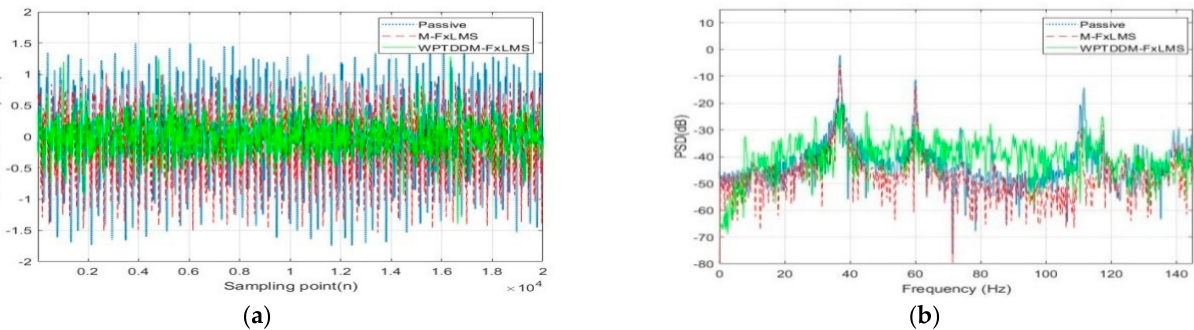
Figure 16. ( a ) The time domain acceleration signal in measuring point 1#; ( b ) the acceleration signal spectrum in measuring point 1#.